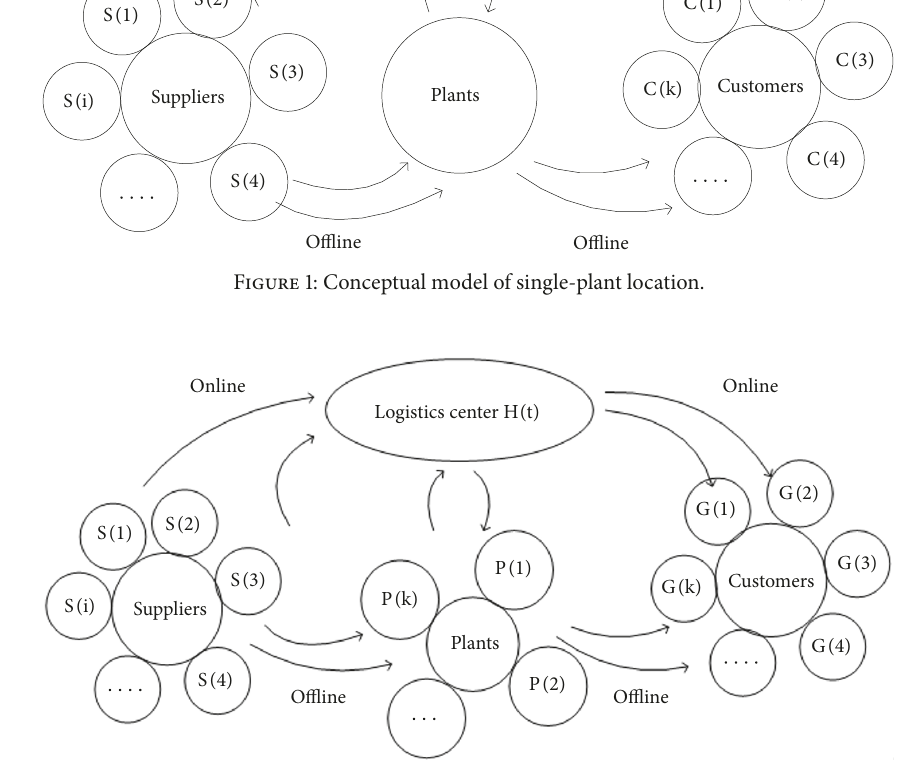
Figure 2: Conceptual model of multiplant